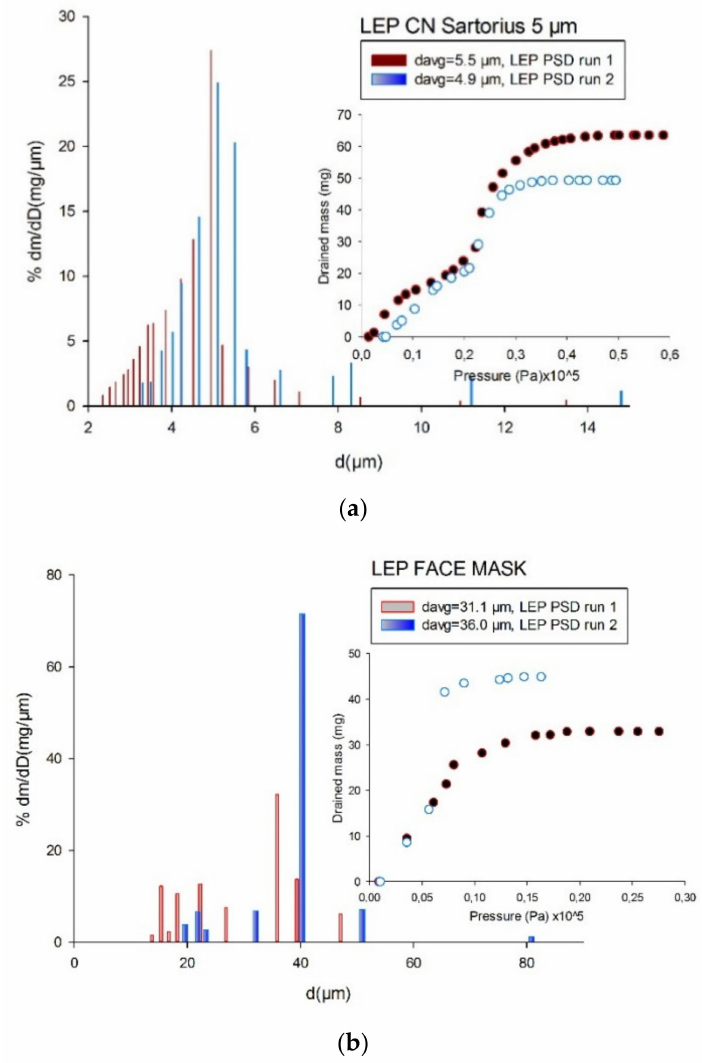
Figure 8. ( a ) Pore-size distributions (PSDs) of the CN membrane and ( b ) face mask as obtained using the Liquid Extrusion Porometry (LEP)